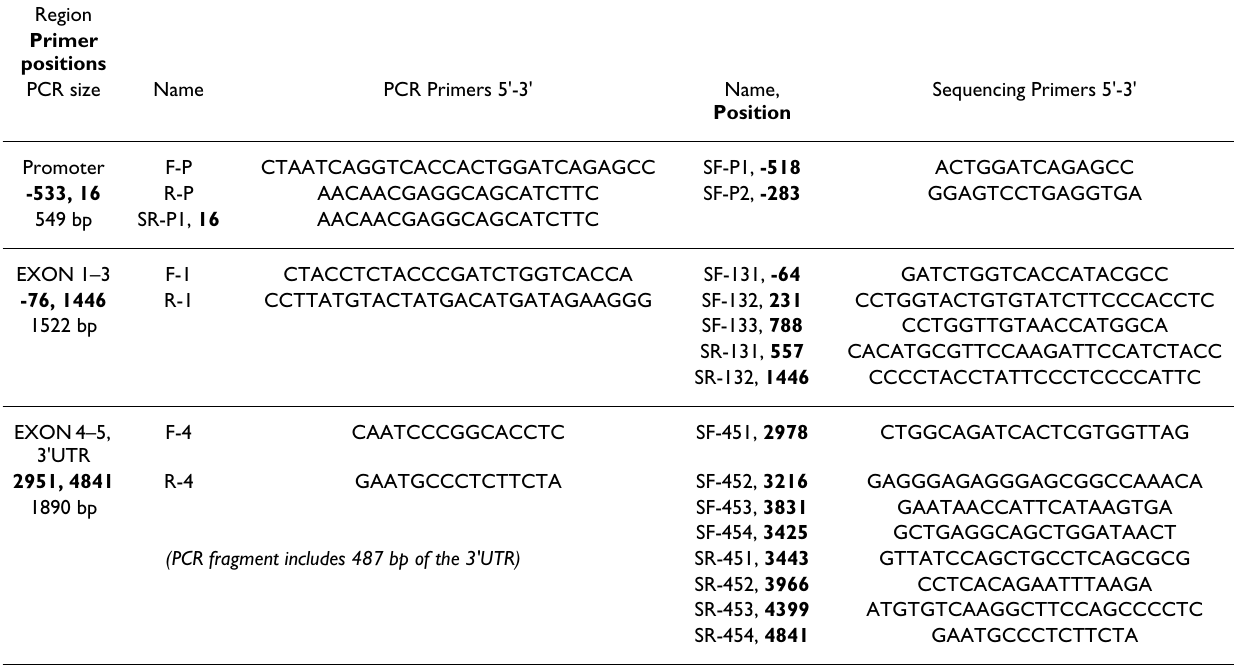
Table 1: PCR and sequencing primers for the OAZ3 gene. An "F" in the name designates a forward primer, an "R" designates a reverse primer. The position given for each primer is that of the first nucleotide, in relation to the first nucleotide of the ATG start codon. Region Primer